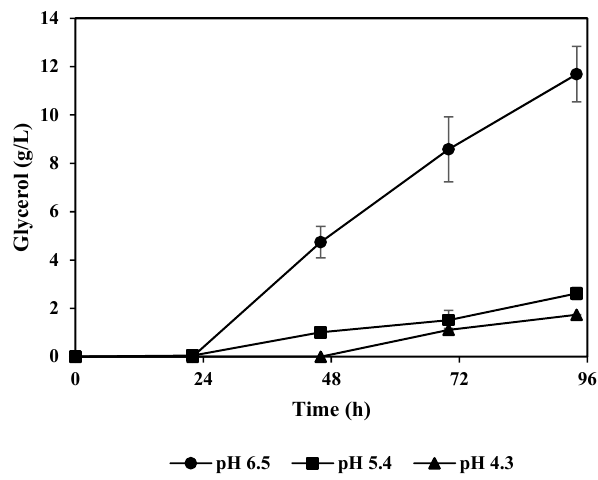
Figure 4. Glycerol yield in pH adjusted crème fraiche medium inoculated by A. oryzae .